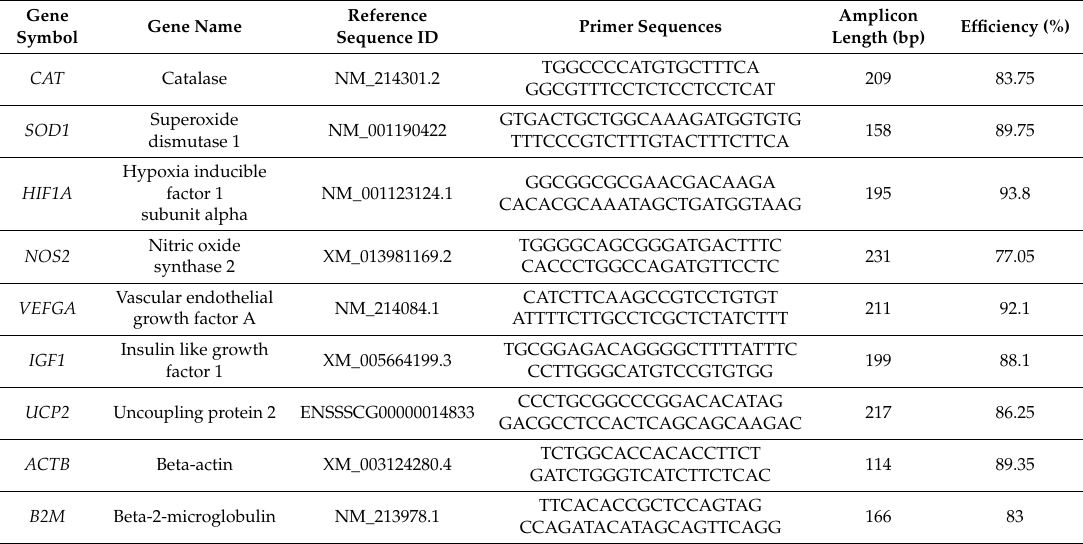
Table 6. Primer design for qPCR and PCR